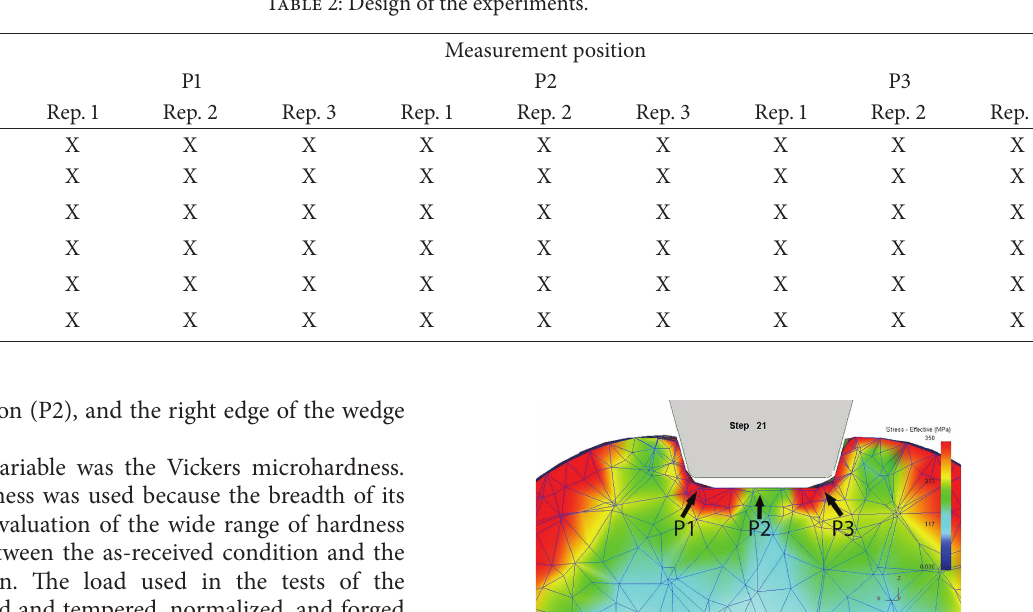
Table 2: Design of the experiments.